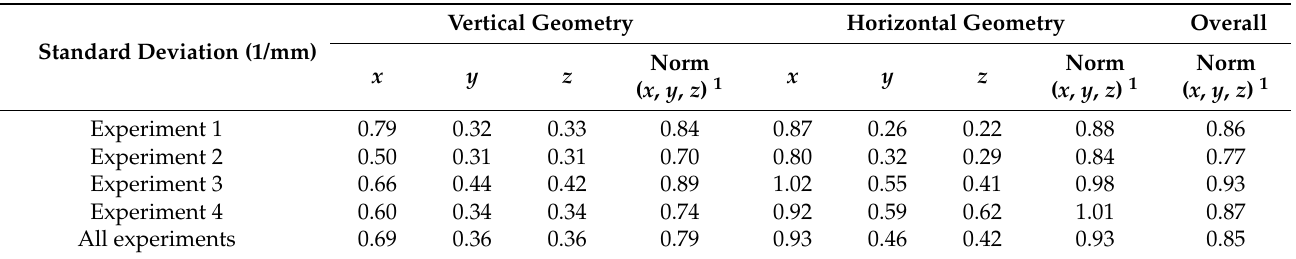
Table 1. Standard deviation of the deviation for x , y , z and the vector length for each experiment and detector geometry.